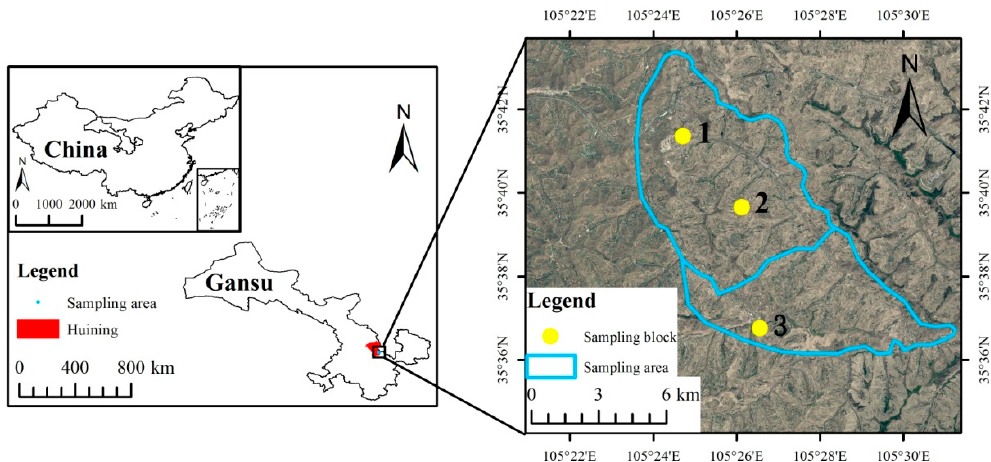
Figure 1. Location of the three experimental blocks in Huining County, Gansu Province, China.